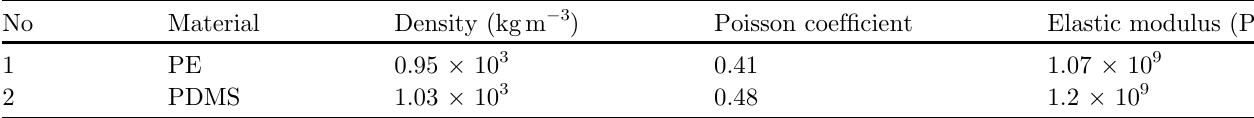
Fig. 4. (a) Cilium MEMS vector hydrophone (CVH); (b) Four-unit MEMS vector hydrophone (FUVH); (c) Anulus-shaped ciliary structure MEMS vector hydrophone (AFUVH). Table 2. Material